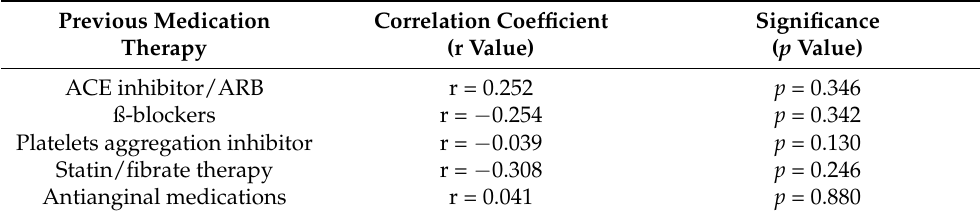
Table 6. Correlation between the previous medication therapy and the PACAP levels.